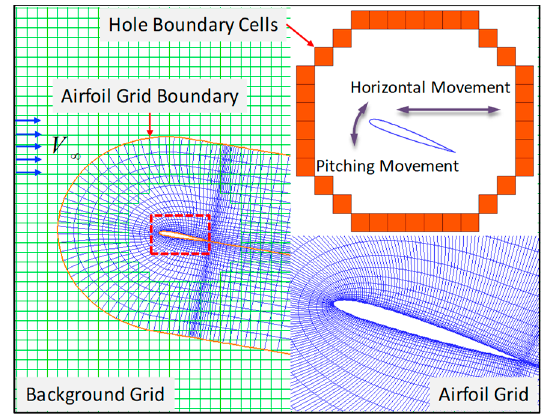
Figure 2. Schematic of moving-embedded grids.